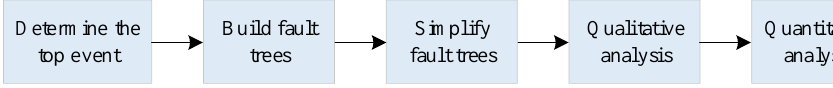
Figure 6. Fault tree of Load B failure.